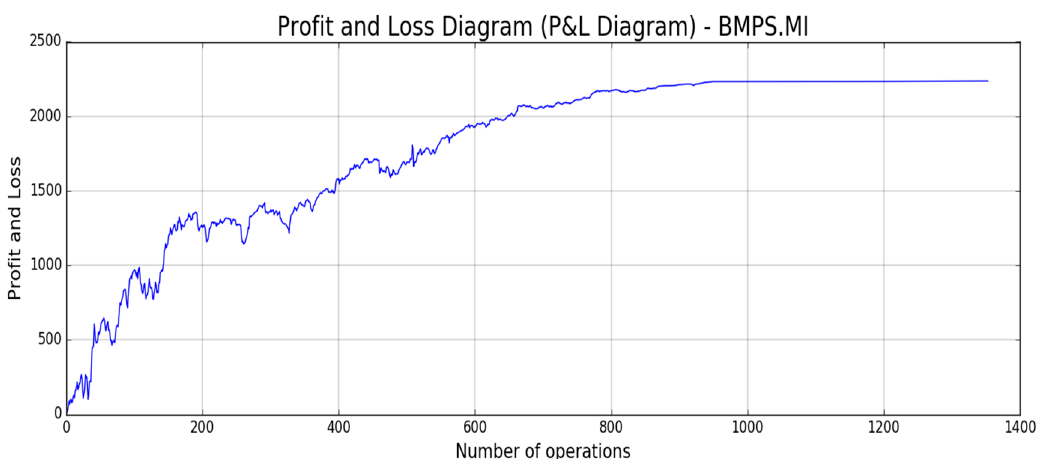
Figure 20. BMPS.MI Profit and Loss Diagram.